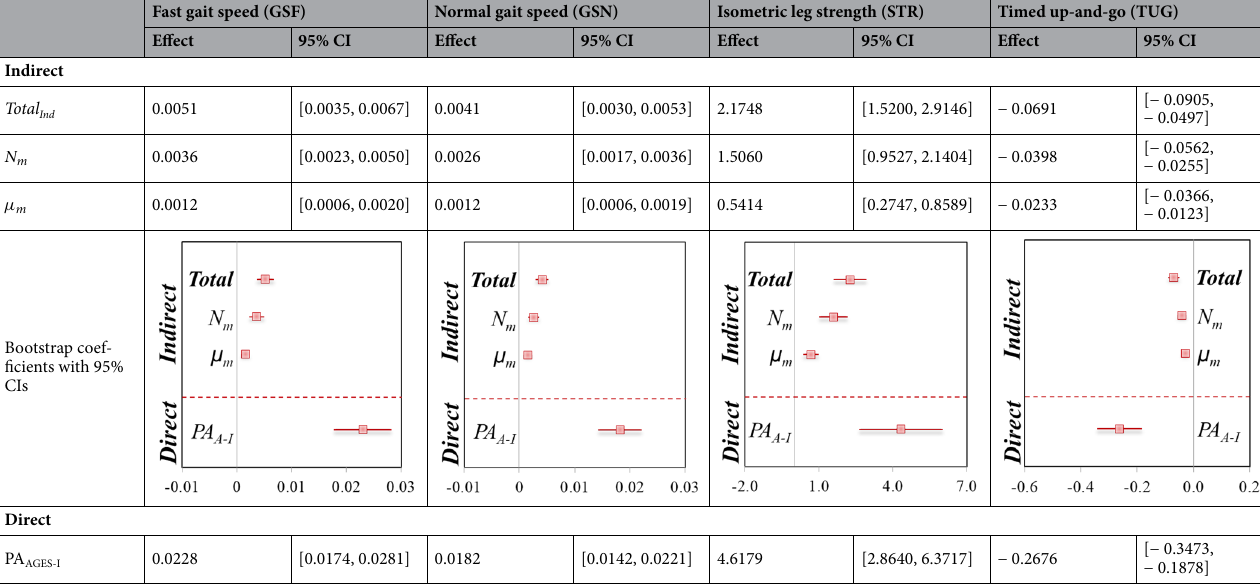
Table 6. Bootstrapped indirect and direct effects analyses for each LEF AGES-II task. 95% CI values for all indirect and direct effects did not include zero; therefore, all model effects are